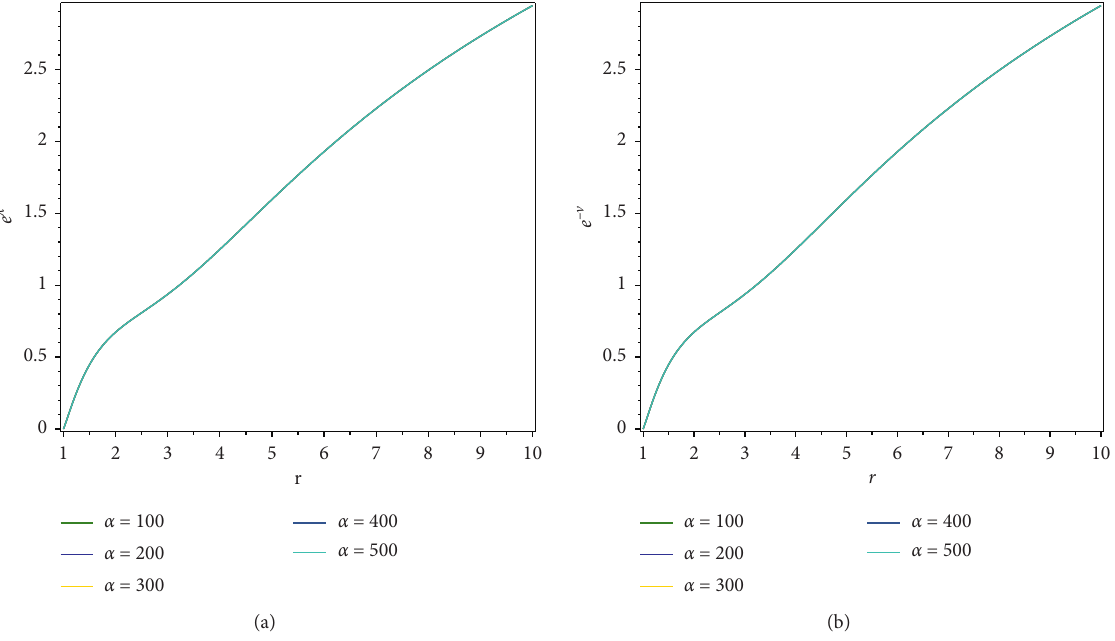
Figure 3: Plots of metric potentials corresponding to r .